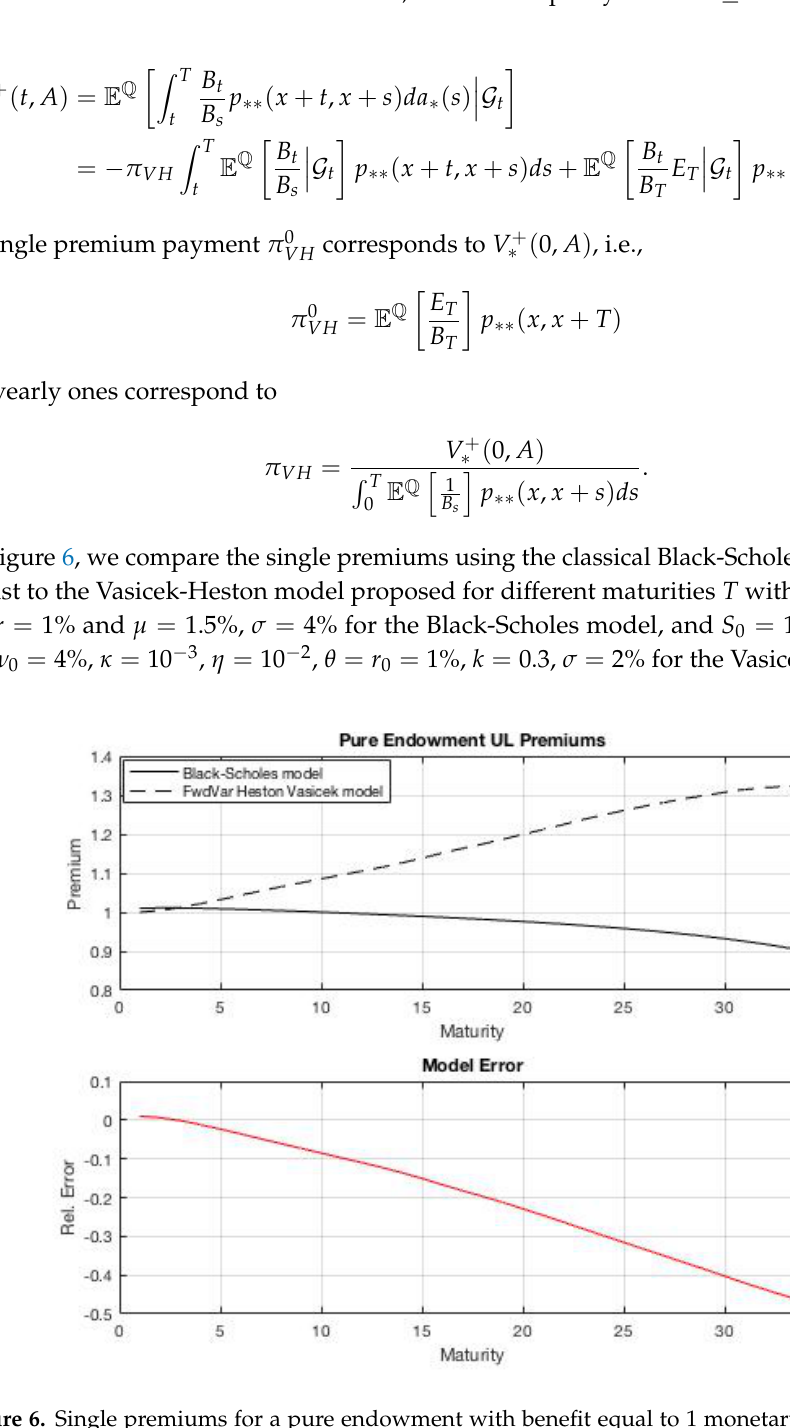
Figure 6. Single premiums for a pure endowment with benefit equal to 1 monetary unit, using the classical Black-Scholes with constant interest r = 1% and µ = 1.5%, σ = 4% and a Vasicek-Heston model with parameters S 0 = 1, µ = 1.5%, ¯ ν = 1%, ν 0 = 4%, κ = 10 − 3 , η = 10 − 2 , θ = r 0 = 1%, k = 0.3, σ =